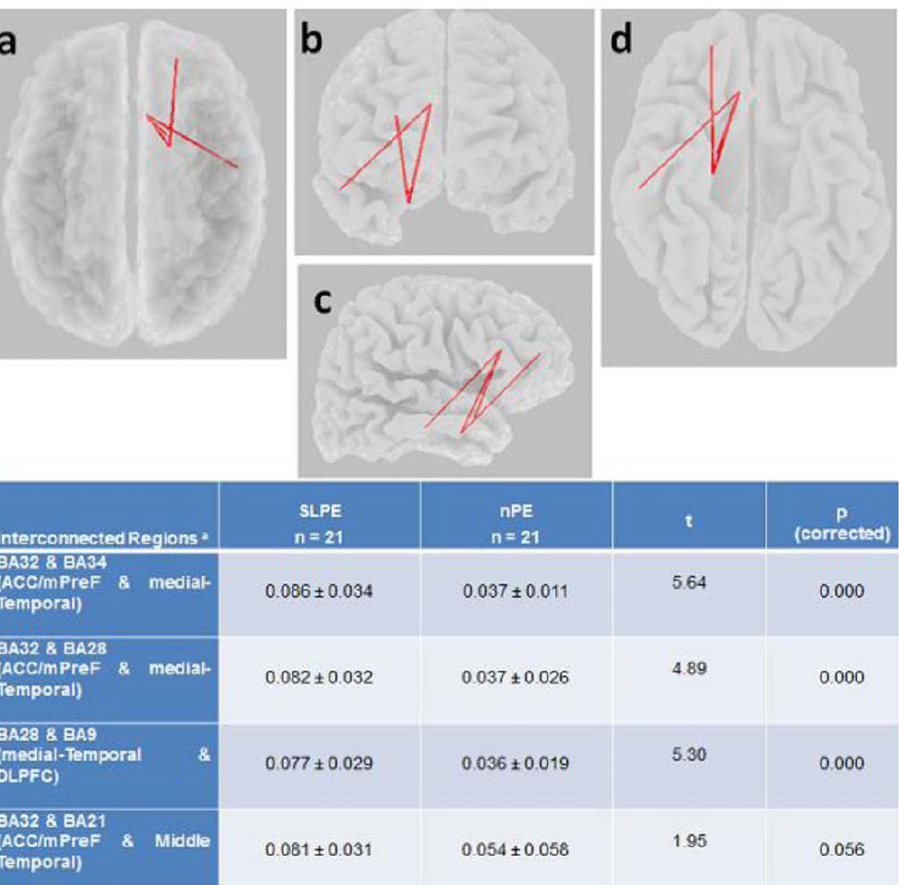
Figure 3. eLORETA wire diagram illustrating significantly increased functional connectivity ( lagged phase synchronization) in the beta2 frequency band in right frontotemporal circuits in patients with schizophrenia-like psychosis of epilepsy vs. those with nonpsychotic epilepsy ( t max =5.6; p , 0.01, corrected). The significant connectivity wires are shown inside a transparent cortical surface with axial views from the top (left) and bottom (right), as well as coronal (top middle) and right sagittal view (bottom middle). The red color of the wire indicates relative increase in phase synchronization (as opposed to a blue wire that would indicate connectivity decrease). Increased beta2 (21–30 Hz) phase synchronization was observed between signals of the Brodmann area (BA) 32 (anterior cingulate/medial prefrontal cortex) and those of BAs 32/ 28 (medial temporal cortex) and BA21 (middle temporal gyrus in the lateral convexity), and between BA 32 and BA 9 (dorsolateral prefrontal cortex). The points to which the lines are connected represent the center of mass of the BAs. The table at the bottom shows the phase synchronization values of the significantly different connections between groups. a Regions in the right hemisphere; SLPE, schizophrenia-like psychosis of epilepsy; nPE, nonpychotic epilepsy; BA, Brodmann area; ACC, anterior cingulate cortex; mPreF, medial prefrontal; DLPFC, dorsolateral prefrontal